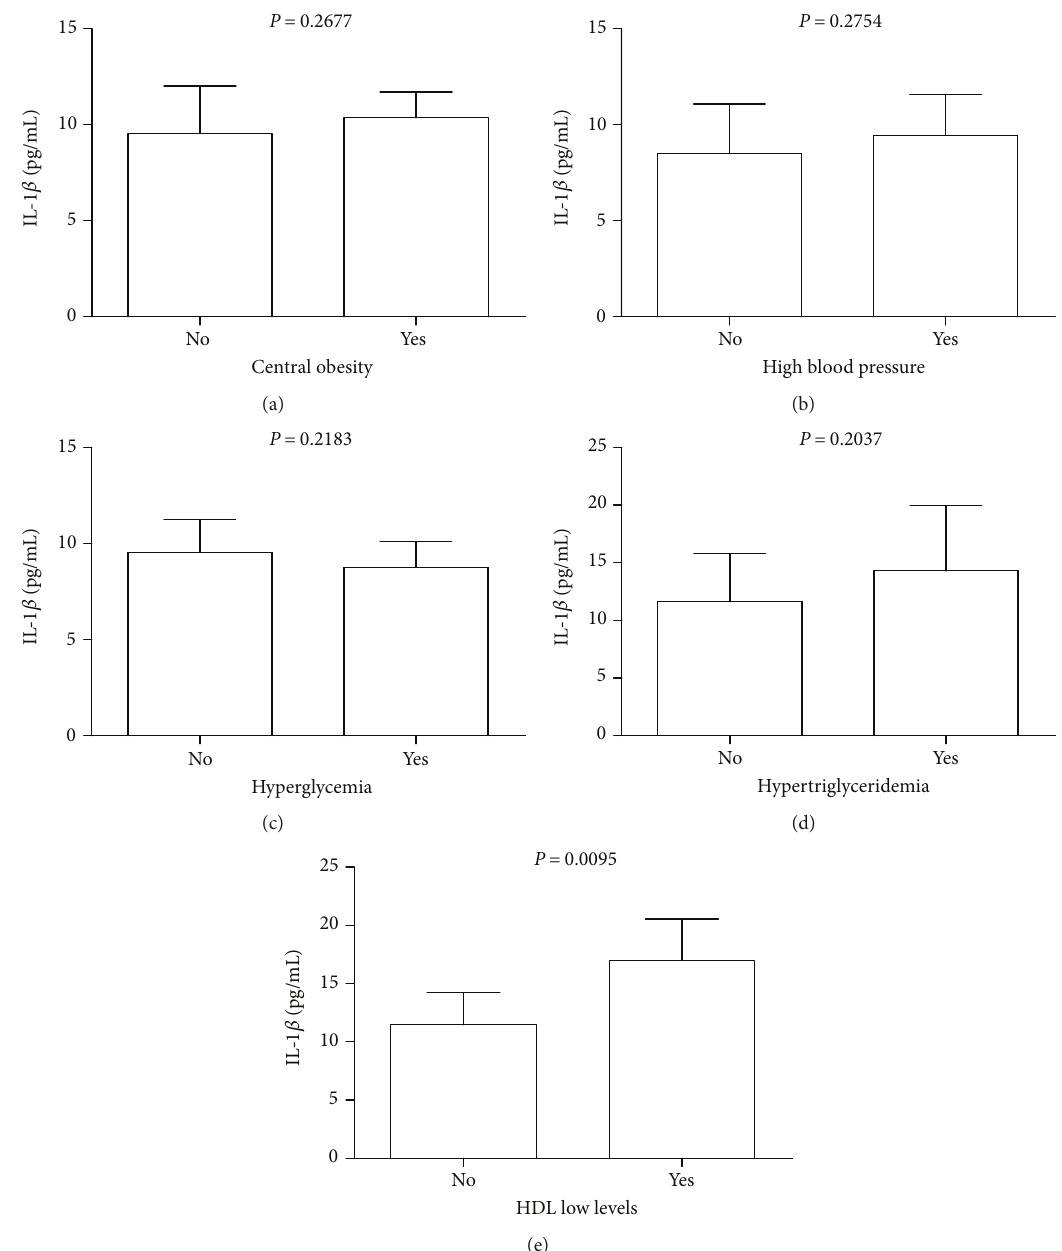
Figure 3: Serum levels of IL-1 β in the study patients according to di ff erent metabolic syndrome risk factors. (a) Metabolic syndrome patients displaying central obesity ( n = 39 ) showed similar IL-1 β serum levels than did metabolic syndrome patients that had a normal waist circumference ( n = 5 ). (b) The serum levels of IL-1 β did not show signi fi cant di ff erences in metabolic syndrome patients with elevated blood pressure ( n = 6 ) as compared to metabolic syndrome patients with normal blood pressure ( n = 38 ). (c) Metabolic syndrome patients showing fasting hyperglycemia ( n = 8 ) exhibited similar IL-1 β circulating levels than did metabolic syndrome patients with normal glycemic values ( n = 36 ). (d) The serum levels of IL-1 β tended to increase in metabolic syndrome patients with hypertriglyceridemia ( n = 23 ) but did not show signi fi cant di ff erences with respect to metabolic syndrome patients showing normal triglyceride values ( n = 21 ). (e) In contrast, IL-1 β was signi fi cantly increased in metabolic syndrome patients with HDL low levels ( n = 34 ) as compared to metabolic syndrome patients exhibiting normal HDL values ( n = 10 ). Data are expressed as mean ± standard deviation . Signi fi cant di ff erences were estimated by means of performing the Mann – Whitney test. Di ff erences were considered signi fi cant when P < 0 05 . Central obesity was diagnosed when women and men had a waist circumference greater than 80 cm and 90 cm, respectively. High blood pressure was diagnosed in women and men with blood pressure values higher than 120/80mmHg. Hyperglycemia was diagnosed in women and men with fasting blood glucose greater than 100mg/dL. Hypertriglyceridemia was diagnosed in women and men with triglyceride values higher than 150mg/dL. Decreased serum values of HDL were established in women and men with HDL serum values lower than 50mg/dL and 40mg/dL,